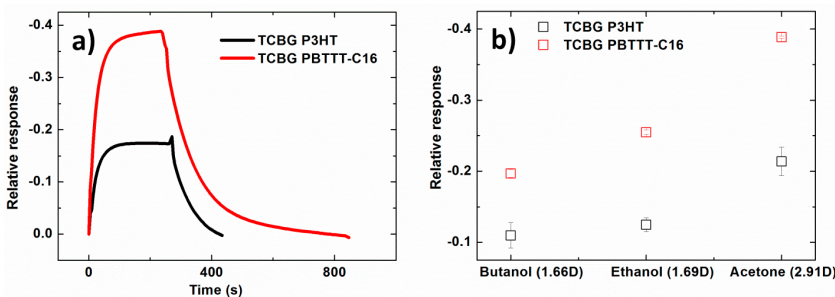
Figure 7. Dynamic relative response of the drain current vs. time of the OTFT-based sensors subjected to the three analytes at the same activity (a PBTTT-C16. ( b ) BCBG PBTTT-C16. ( c ) TCBG P3HT. ( d ) BCBG